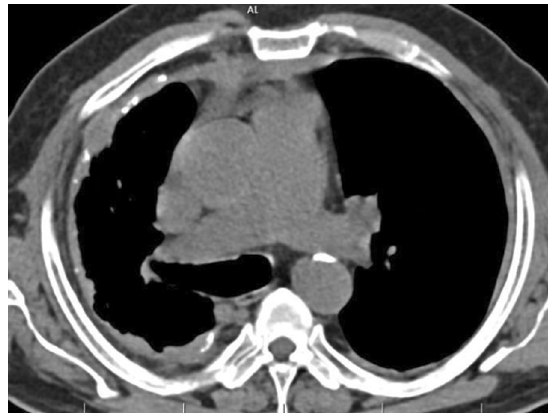
Fig. 6 69‑year‑old male patient presented with cough, dyspnea and chest pain. Axial CT mediastinal window images showing extra‑pleural fatty expansion and soft tissue stranding in a case of mesothelioma on top of asbestos exposure